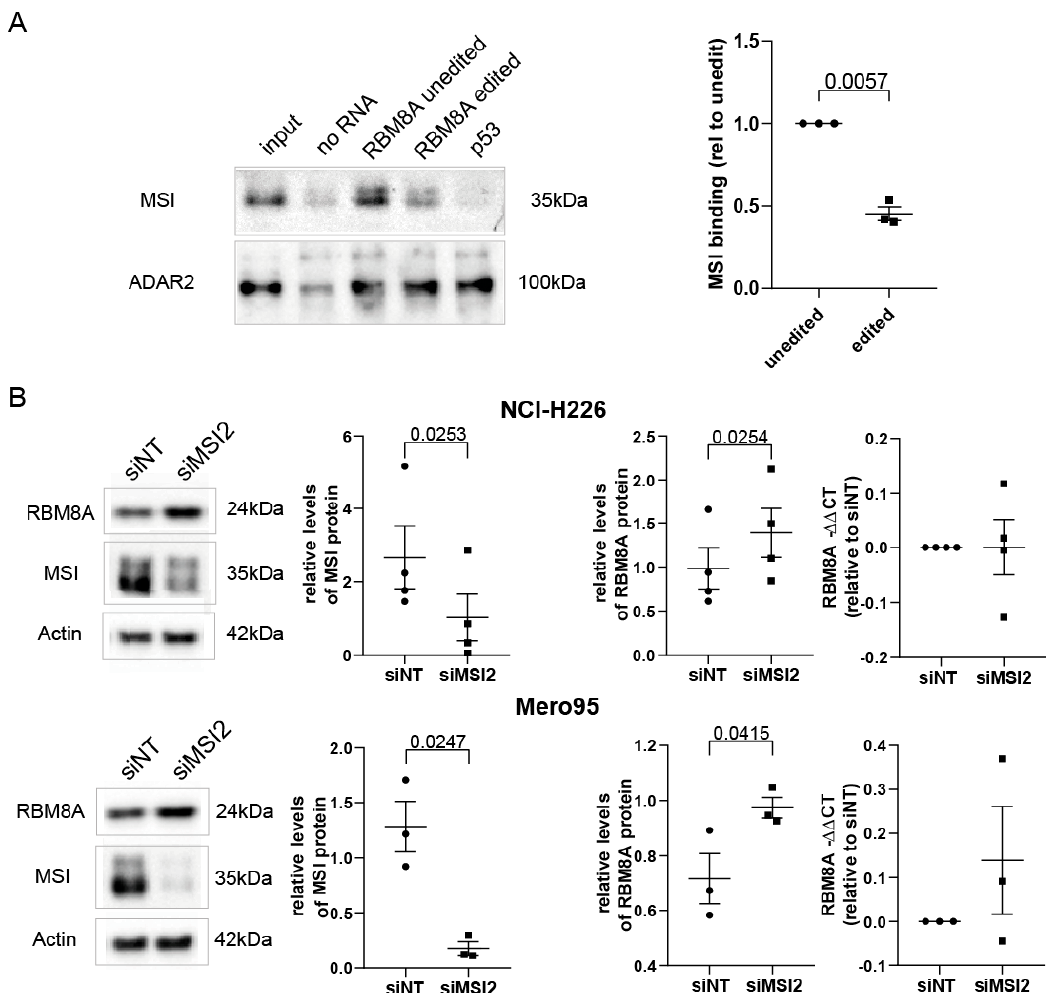
Figure 5. Unedited RBM8A 3 ′ UTR binds MSI2, and silencing MSI2 increases RBM8A protein levels. ( A ) Upper panel: in vitro transcribed unedited RBM8A 3 ′ UTR preferentially binds MSI2, a negative regulator of translation, compared to the edited sequence. TP53 RNA, which has only 1 potential MSI binding site, was used as a negative control, and ADAR2 was used as a positive control. Lower panel: quantification of MSI binding to the edited RBM8A RNA sequence relative to unedited after normalization to ADAR2. Paired t -test. ( B ) Silencing of MSI2 in NCI-H226 (upper panel) and Mero95 (lower panel) cells results in decreased MSI and upregulation of RBM8A protein levels, while RBM8A mRNA levels are maintained. Paired t -test.